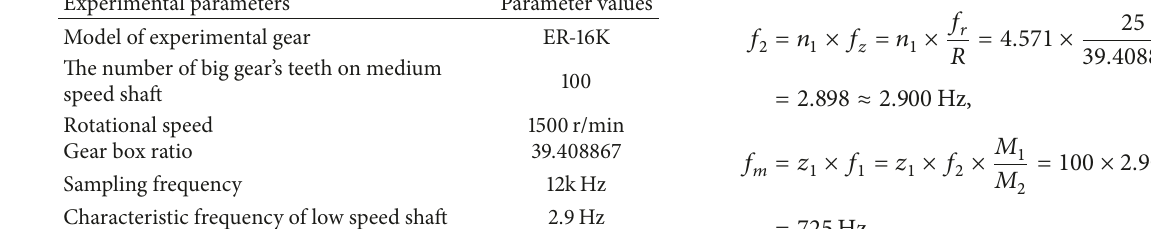
medium-speed shaft is 100. The meshing frequency of the gear can be calculated as